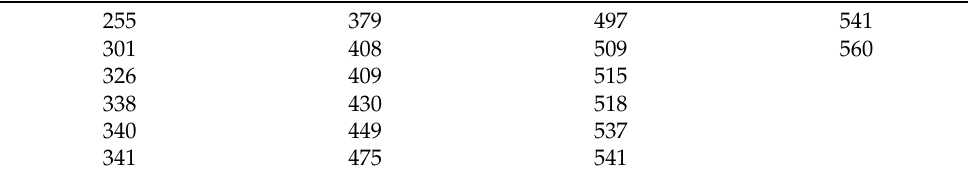
Table 3. Failure Cycles for the 20 observed